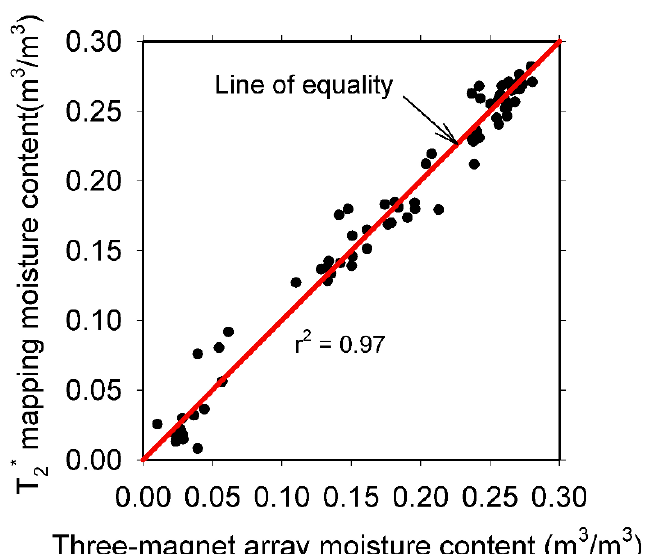
Figure 10. Three-magnet array moisture content versus the moisture content obtained with the T 2 * mapping of all the mortar samples tested.